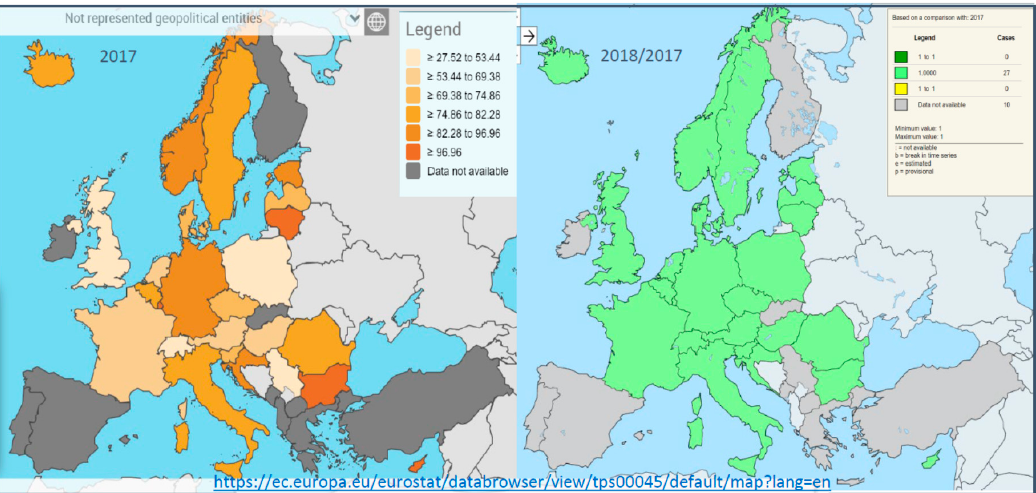
Figure 32. Number of practicing dentists in various European countries per 100,000 inhabitants in 2017 and the rate of changes in the number of dentists in 2018 compared to 2017.